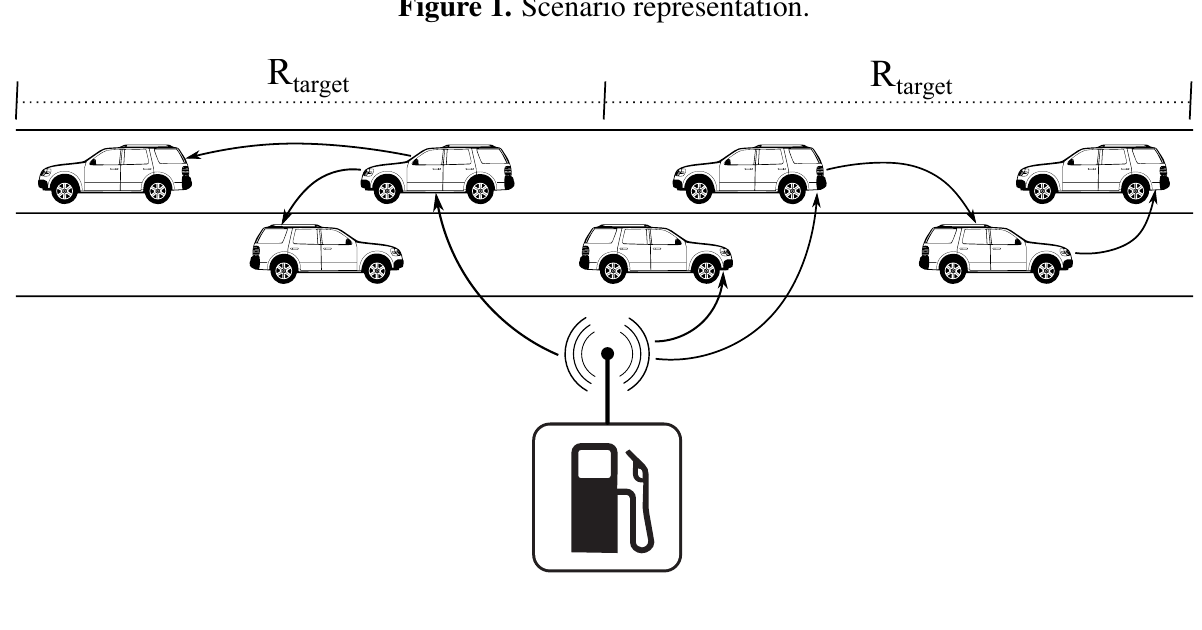
Figure 1. Scenario